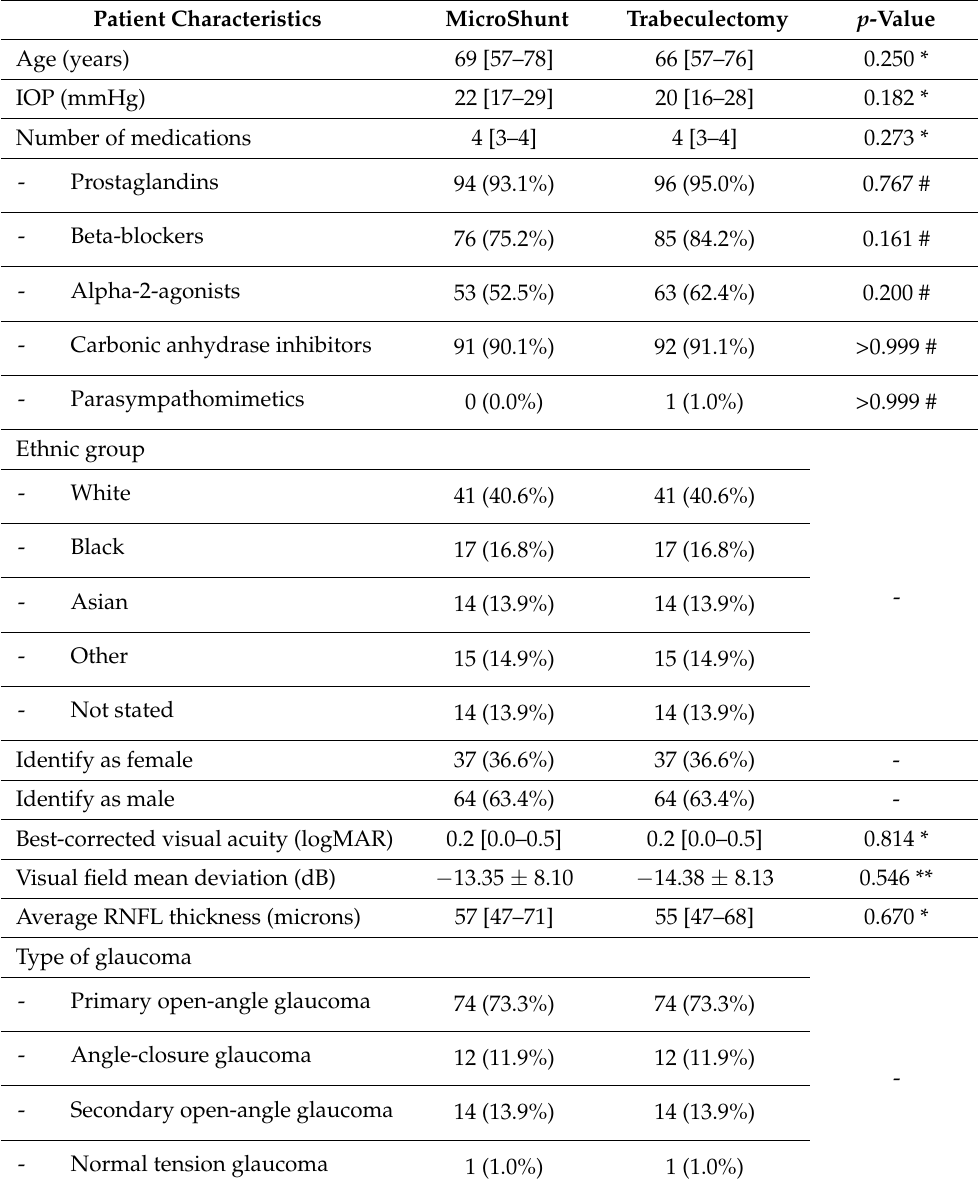
Baseline demographics and characteristics. Data are expressed as